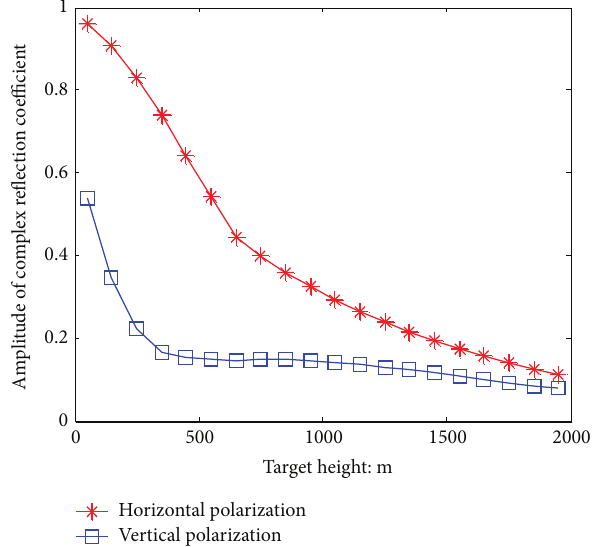
Figure 7: Amplitude of complex reflection coefficient varies with target